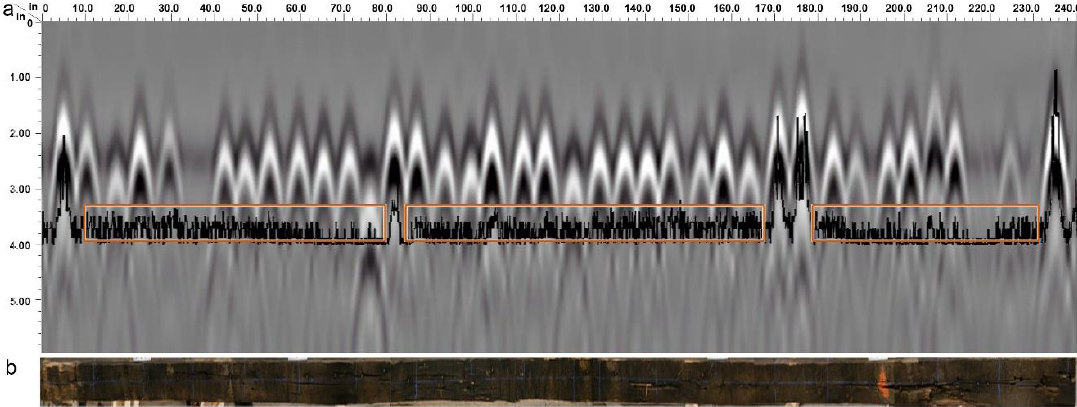
Figure 14. The combined image for the line chart of DTW value, the radargrams generated from RADAN 7, and the outside camera pictures (sample No. 13). ( a ) The results made up of the radargrams and the line chart of similarity; ( b ) The outside image of one side of No. 13 timber.